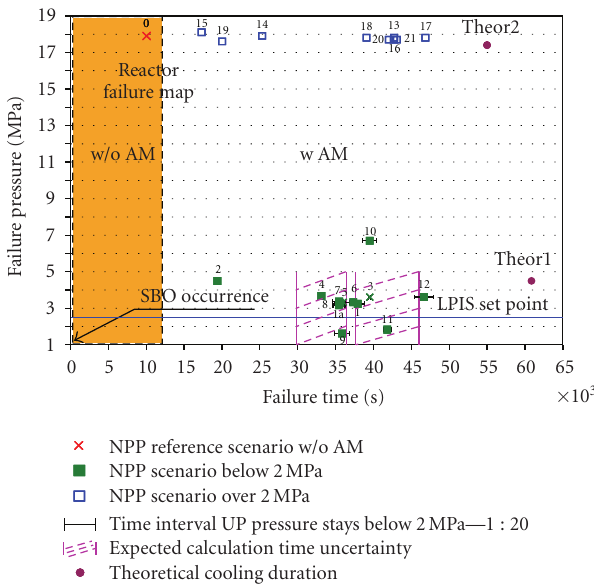
Figure 1: “AM map” for VVER-1000 NPP following station